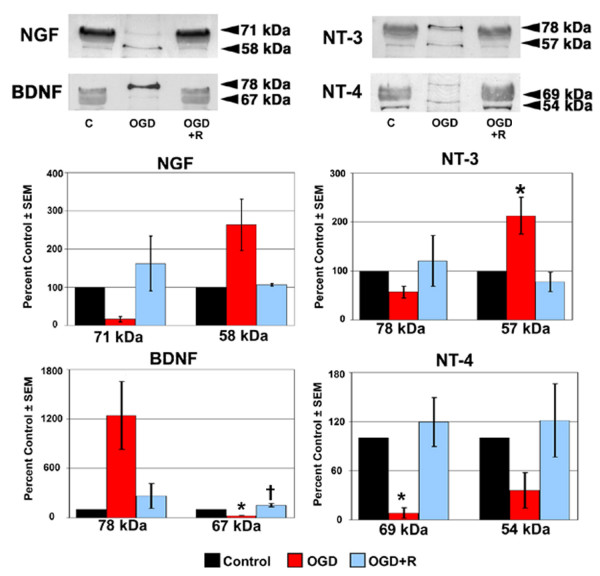
NT protein expression in LC cells following exposure to and recovery from Oxygen-Glucose Deprivation. Lamina cribrosa cells were exposed to OGD for 48 hours (OGD) or to 48 hours OGD followed by recovery for 24 hours (OGD+R). Cells exposed to growth media and 95% air/5% CO2 for 48 hours served as controls (C). Cell lysate was separated by SDS-PAGE and the density of unsaturated bands was measured for each blot. A representative blot for each NT is shown. Band density reported as mean percent of the control ± SEM (n = 3) is shown graphically beneath the blots. * indicates p < 0.016 for OGD compared to C and OGD+R; † indicates p < 0.016 for OGD+R compared to C (one way analysis of variance [ANOVA] followed by validation using Student-Newman-Keuls tests).